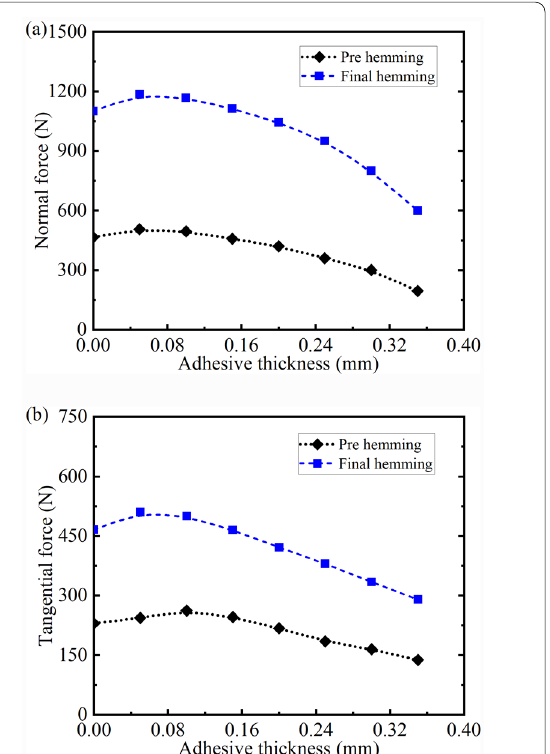
Figure 15 Evolution of external force with flanging height: (a) Normal force, (b) Tangential force